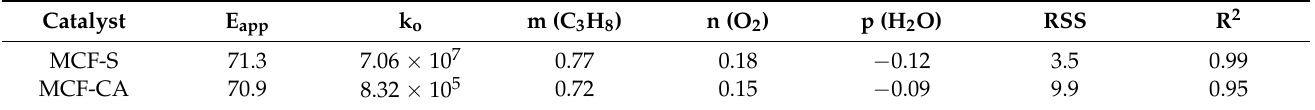
Table 4. Estimated kinetics parameters for the power—law